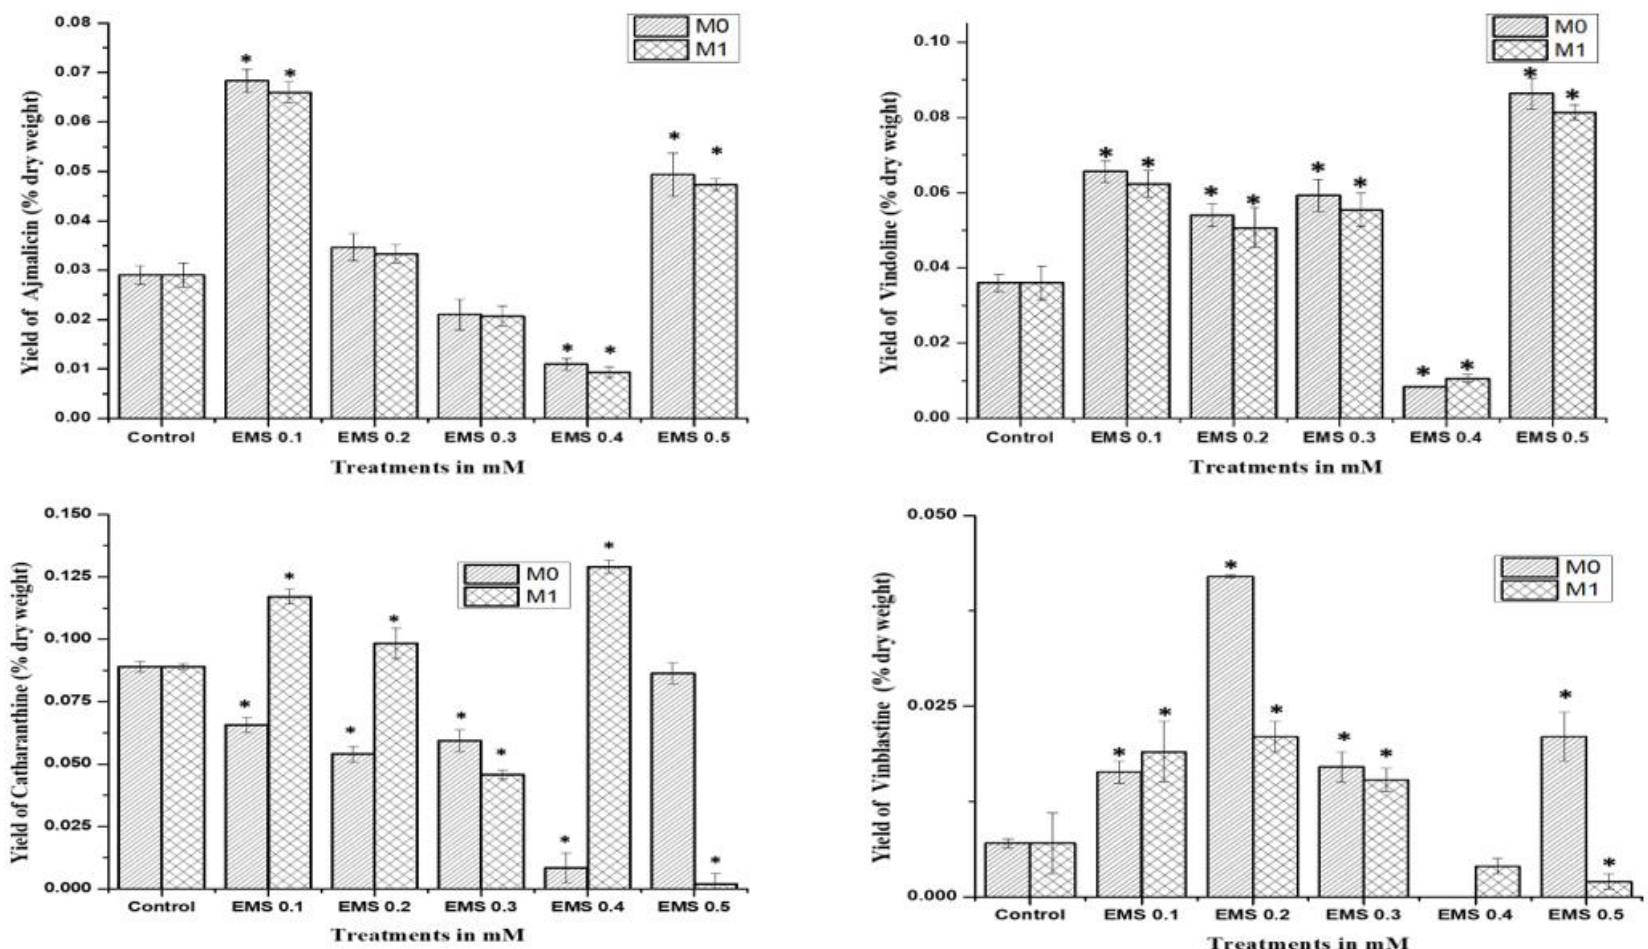
Figure 5. HPLC analysis of the key MIAs ajmalicine, catharanthine, vindoline, and vinblastine in EMS-mutated M 0 –M 1 and control C. roseus plants. * represents a significant difference from the respective control at p < 0.05 after applying post hoc Dunnett’s test ( n = 3).